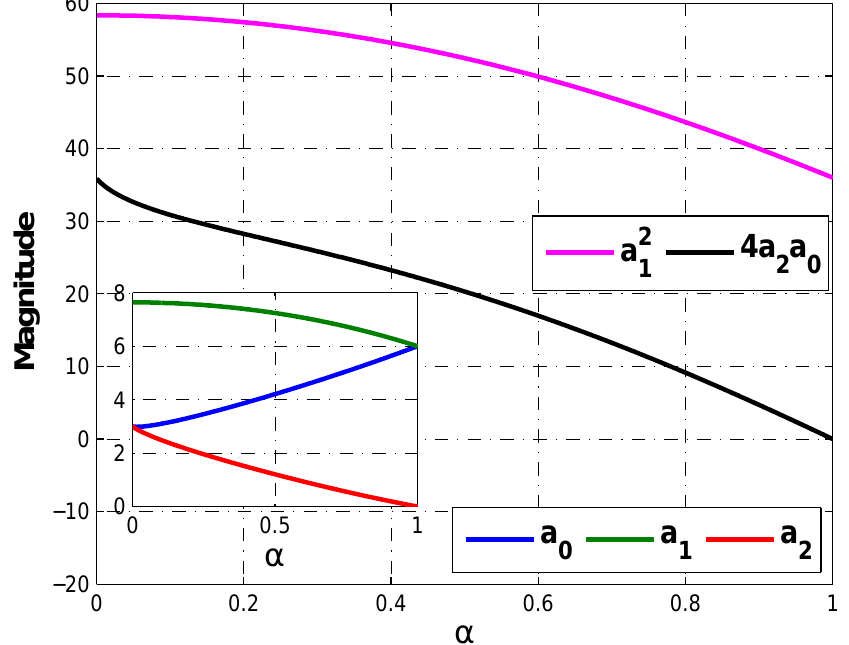
> 4 a 2 a 0 holds. 1